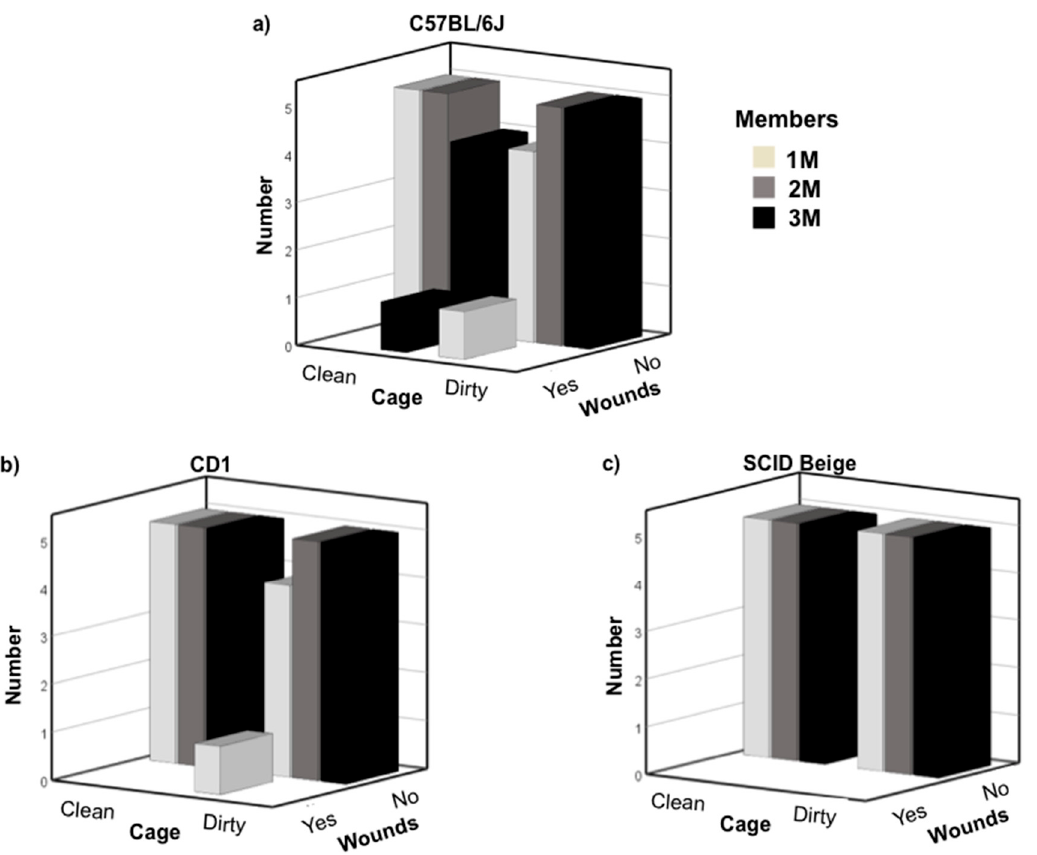
Figure 1. Number of cages in which wound due to fights were observed; ( a ) C57BL/6J ( b ) CD1 and ( c ) SCID Beige newly weaned mice after grouping with late juvenile male mice. X-axis shows the condition of the cage, clean or dirty. Z-axis shows whether there were or were not wounds due to fights. White bars indicate cages with one member; grey bars two members and black bar three members’ cages. A total of 30 cages per strain were analyzed, five cages per condition.